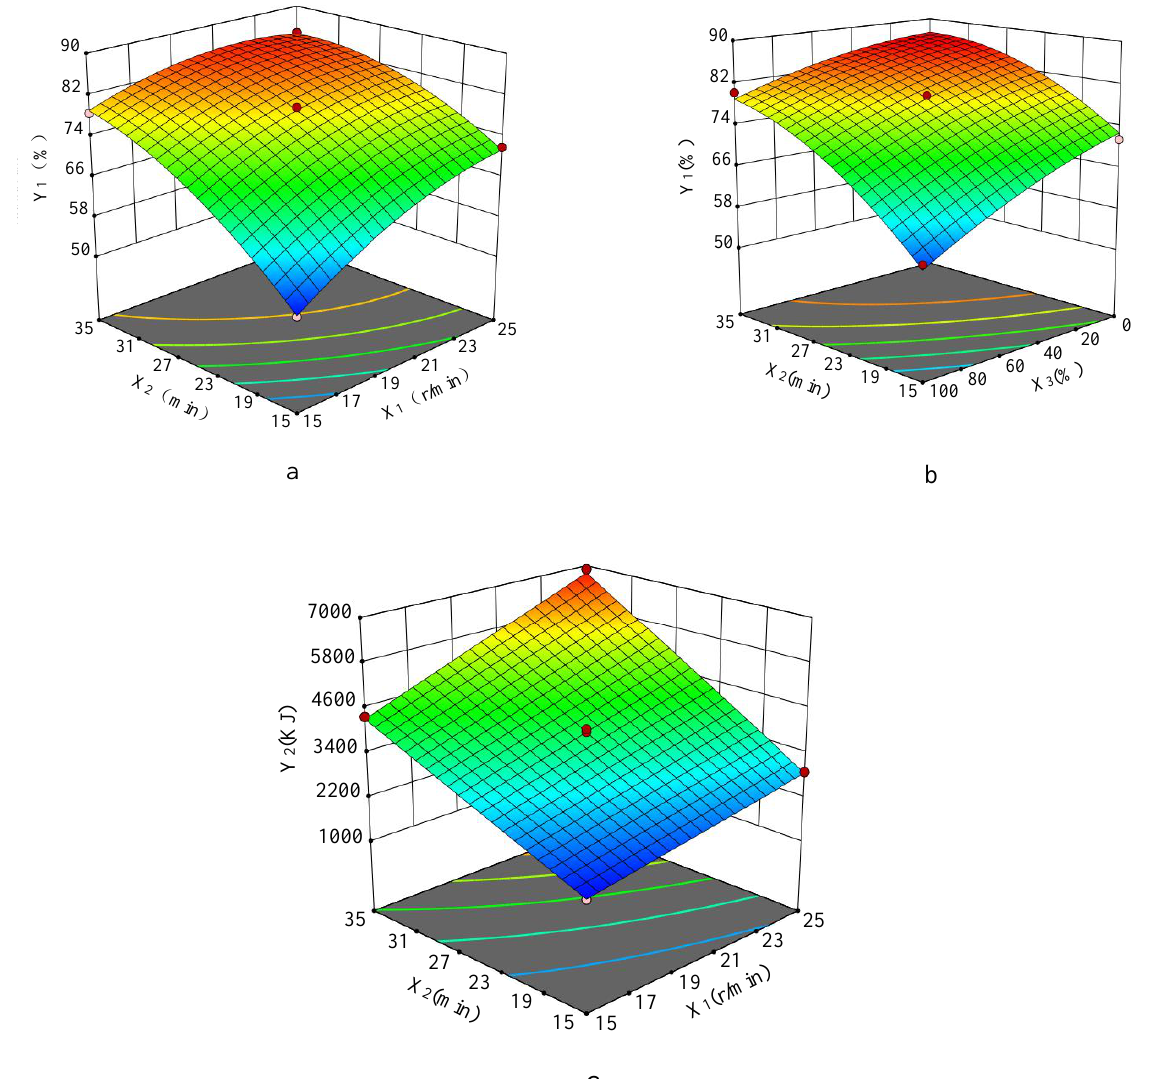
Figure 5. Interaction effects of interaction factors on standard straw length Y 1 and power consumption Y 2 . ( a ) Interaction response surface diagram of processing time and auger speed on standard straw length. ( b ) Interaction response surface diagram of processing time and blade type on standard straw length ( c ) Interaction response surface diagram of auger speed and processing time on power